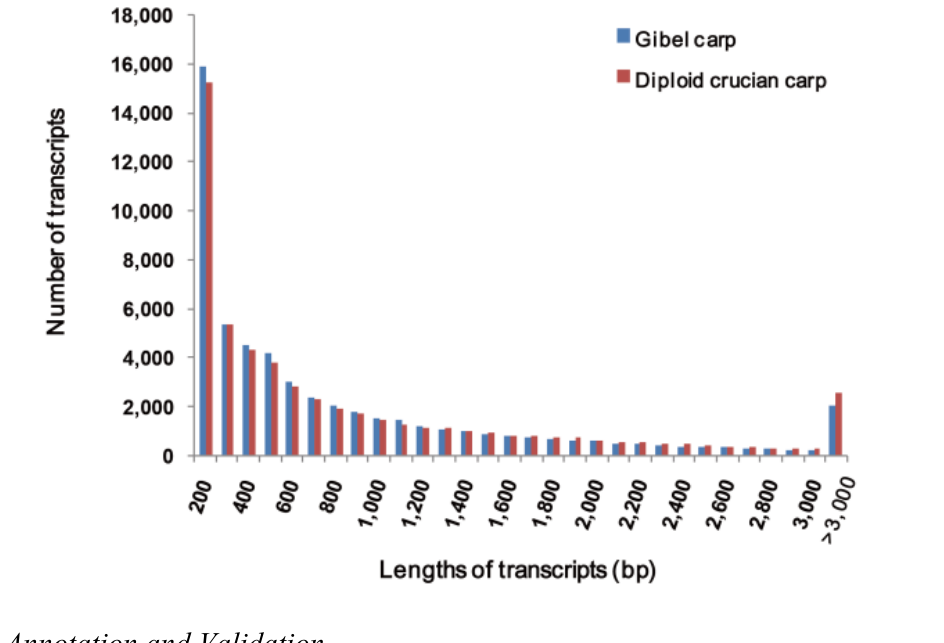
Figure 1. The length distributions of gibel carp transcripts and diploid crucian carp transcripts.